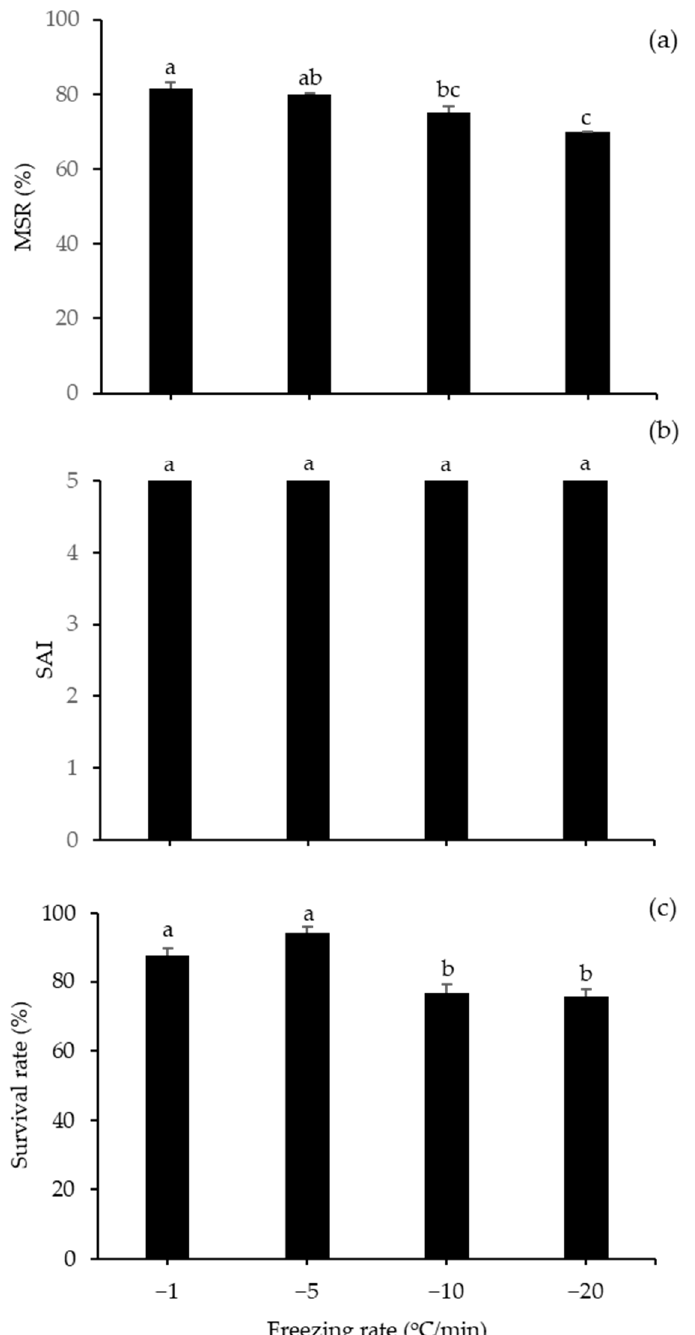
Figure 5. Performance of spotted halibut frozen–thawed sperm for various freezing rates ( − 1, − 5, − 10, and − 20 °C/min) with 15% DMSO and 300 mM sucrose: ( a ) MSR; ( b ) SAI; ( c ) survival rate. Different lowercase letters suggested important variations among freezing rates ( p < 0.05).